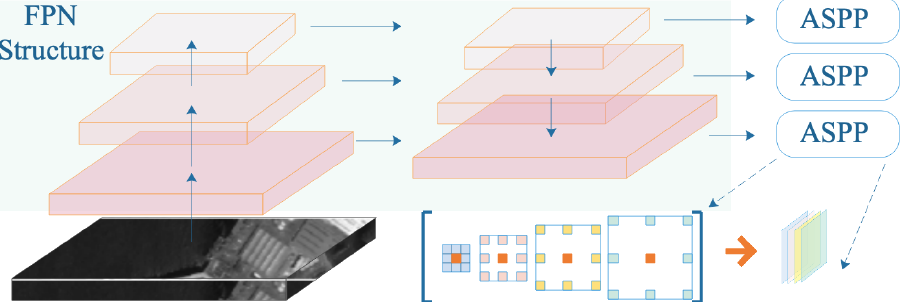
Figure 6. Schematic diagram of the RFE